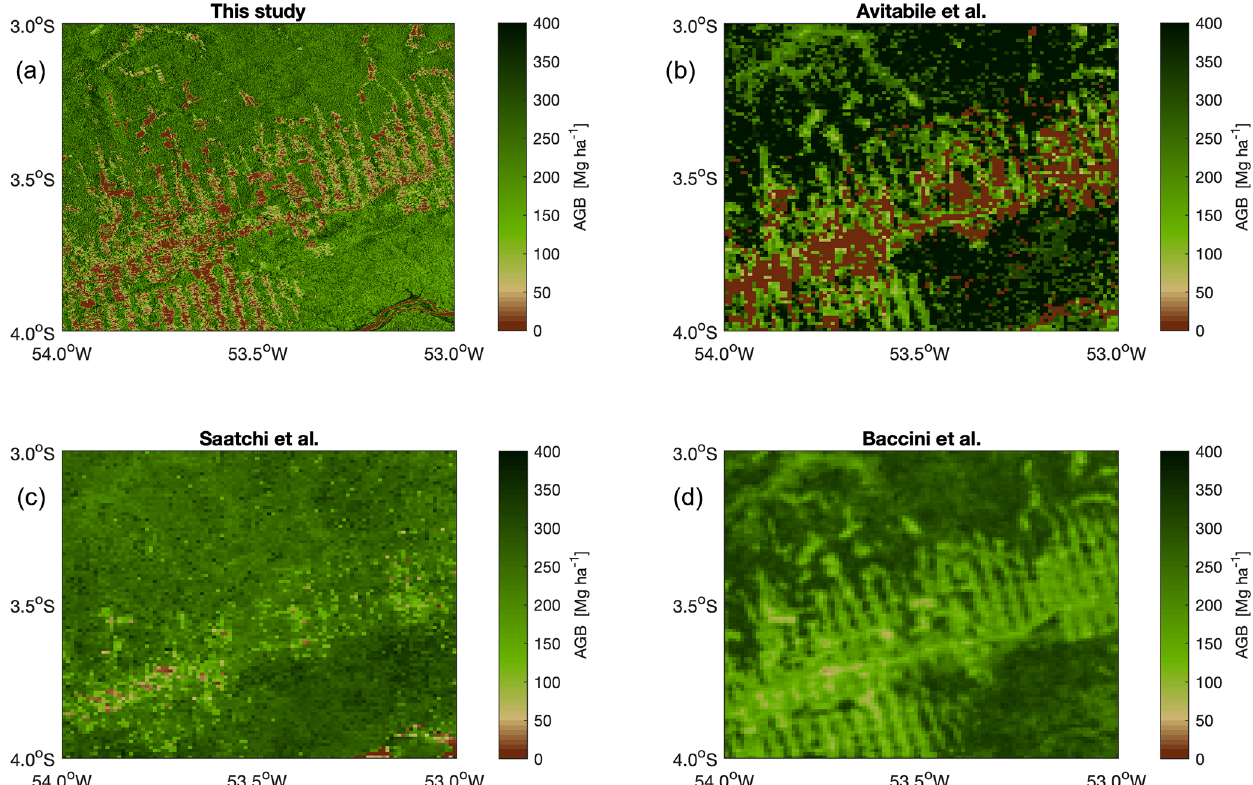
Figure 4. AGB estimates by this study (a) , Avitabile et al. (2016) (b) , Saatchi et al. (2011b) (c) , and Baccini et al. (2012) (d) for a 1 ◦ × 1 ◦ area in the state of Parà, Brazil.